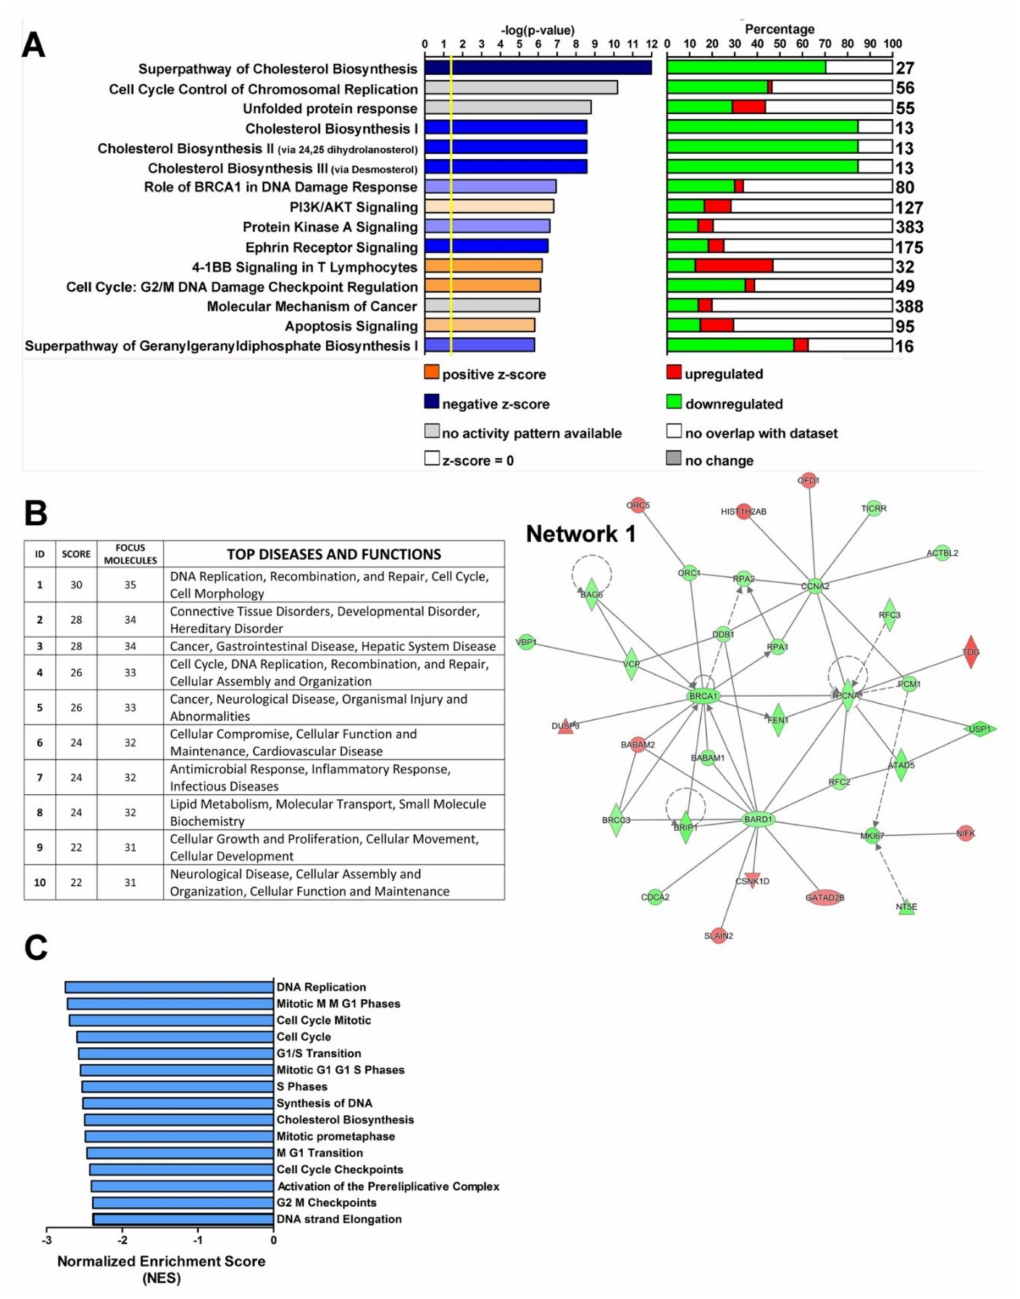
Figure 2. Functional analysis performed on differentially expressed genes in U94 + cells. ( A ) Top 15 canonical pathways differentially regulated between U94 + and EGFP + MDA-MB 231 cells. These pathways are the results of Ingenuity Pathway analysis (IPA) “Core Analysis” conducted on 2381 genes with FDR < 0.05 differentially expressed between U94 + and EGFP + MDA-MB 231 cells. Graph shows category scores. The yellow line (threshold) indicates the minimum significance level (scored as − log( p -value) from Fisher’s exact test). Stacked bar chart shows the percentage of genes downregulated (green), upregulated (red) and genes not overlapping with our data set (white) in each canonical pathway. The number at the top of each bar indicates the total number of genes present in the considered canonical pathway. ( B ) Top 10 molecular networks revealed by IPA analysis of 2381 genes with False Discovery Rate (FDR) < 0.05 differentially expressed between U94 + and EGFP + MDA-MB 231 cells. (Right Panel) The most significant molecular network, “DNA Replication, Recombination and Repair, Cell Cycle, Cell Morphology”. Node color indicates up- (red) and downregulated genes (green). Node shapes represent functional classes of gene products. ( C ) Barplot of the Normalized Enrichment Score (NES) for the top 15 significant pathways identified by GSEAPreranked analysis comparing U94 + and EGFP + MDA-MB 231 breast cancer cell